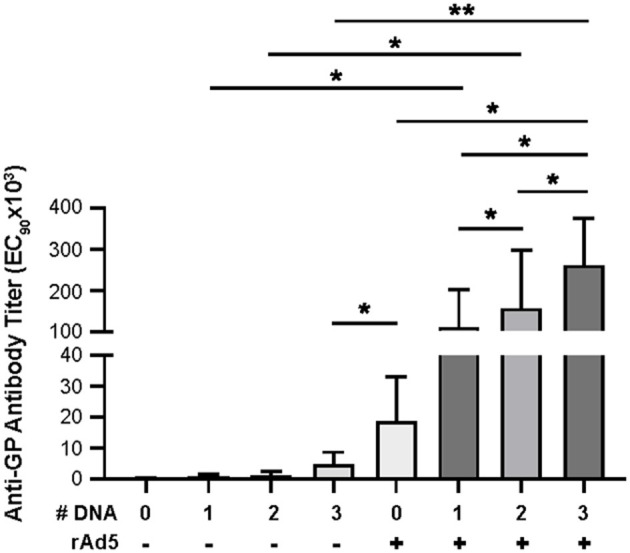
Anti-GP antibody secretion. Anti-GP specific antibodies were detected in immunized NHP sera using ELISA. Sera were diluted from 1:50 to 1:50,000 in half-log increments. Goat anti-human IgG HRP 1:5,000 was used as secondary antibody. ELISA titers are expressed as EC90 values, the dilution at which there is a 90% reduction in antigen binding. Statistical analysis between more than two groups was performed using a one-way ANOVA with Tukey's post hoc test; *p < 0.05; **p < 0.01; mean ± standard deviation shown.